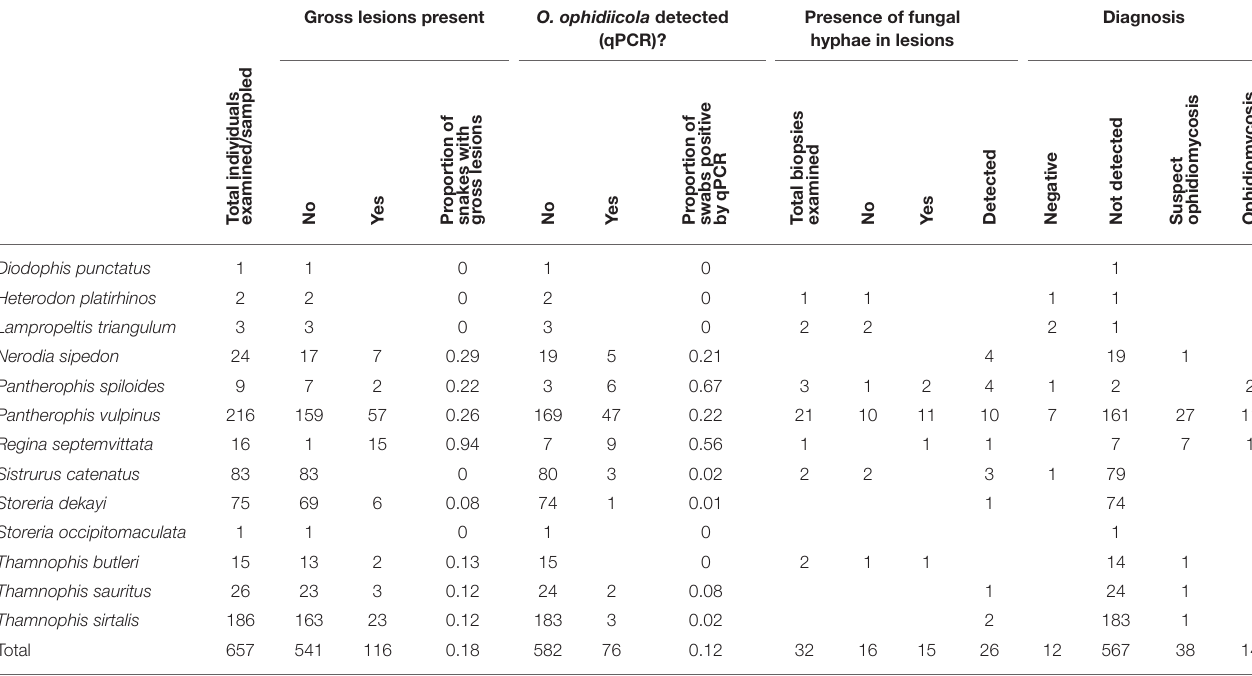
TABLE 2 | Clinical signs of ophidiomycosis (presence of gross lesions and of hyphae in lesions by histopathology) and detection of Ophidiomyces ophidiicola through qPCR, from 657 snakes in southern Ontario, Canada, for which samples were submitted to the Canadian Wildlife Health Cooperative between 2012 and 2018. Gross lesions present O. ophidiicola detected